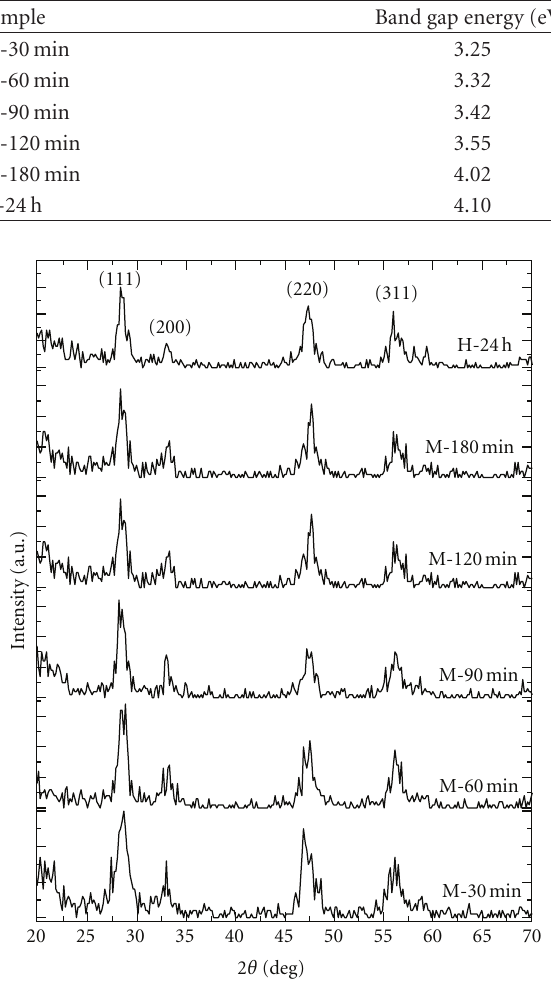
Table 3: The band gap energy of CeO 2 -SiO 2 samples.